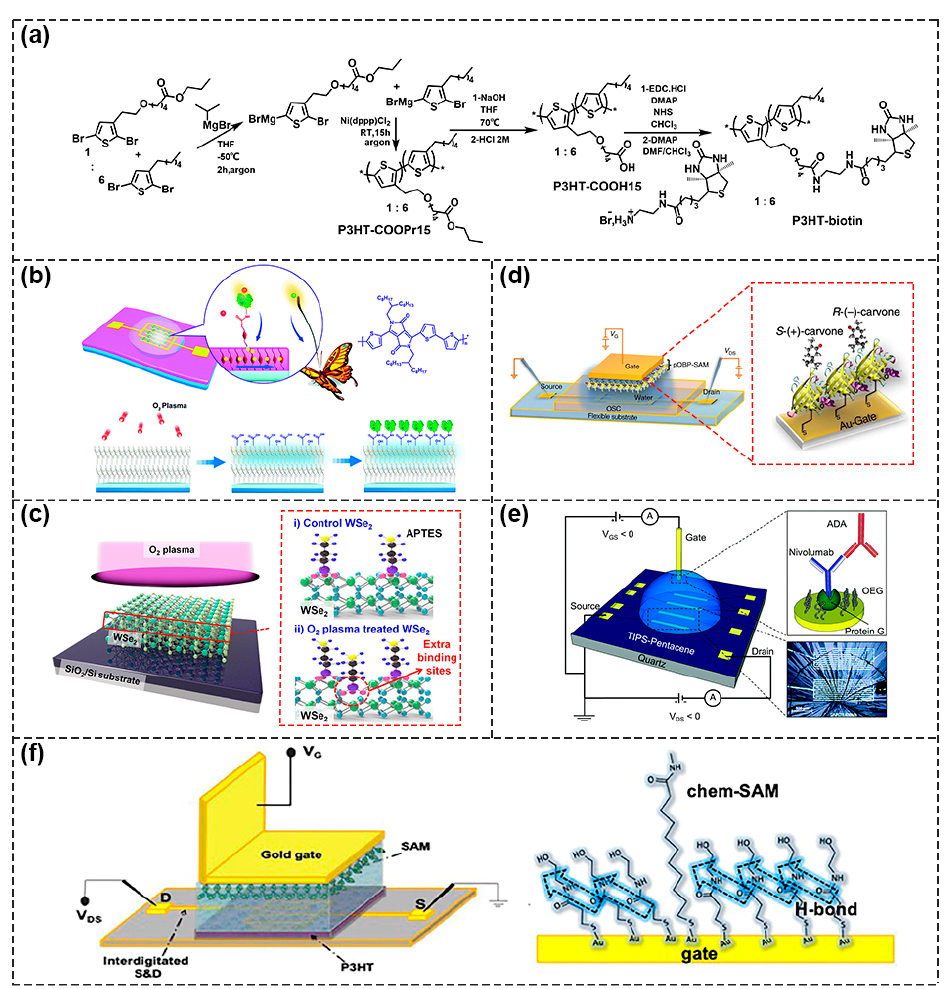
Figure 5. Schematic diagram of chemical functionalization methods. ( a ) The synthesis of a bioti- nylated polymer semiconductor consisting of carboxyl groups and biotin groups. Reproduced with permission from [31]. Copyright 2013, The Royal Society of Chemistry. ( b ) Schematic of the method of plasma − assisted − interface − grafting to introduce molecular antennas on the surface of semicon- ductor. Reproduced with permission from [33]. Copyright 2018, The Royal Society of Chemistry. ( c ) Schematic diagram of O 2 plasma treated WSe 2 flakes. Reproduced with permission from [36]. Copyright 2018 American Chemical Society. ( d ) Schematic representation of the SAMS layer on the gold surface by Au − S chemical bonds. Reproduced with permission from [37]. Copyright 2015, Macmillan Publishers Limited. ( e ) Schematic of the thiol groups of cysteine combined with Au gate to bind with Cys − protein G for detecting the F C fragment of ADA. Reproduced with permission from [38]. Copyright 2021, The Royal Society of Chemistry. ( f ) Schematic diagram of the device structure using both Chem − SAM and Bio − SAM to modify the gate ( left ). Schematic of hydrogen bond network originated from Chem − SAM ( right ). Reproduced with permission from [40]. Copy- right 2020, American Chemical Society.